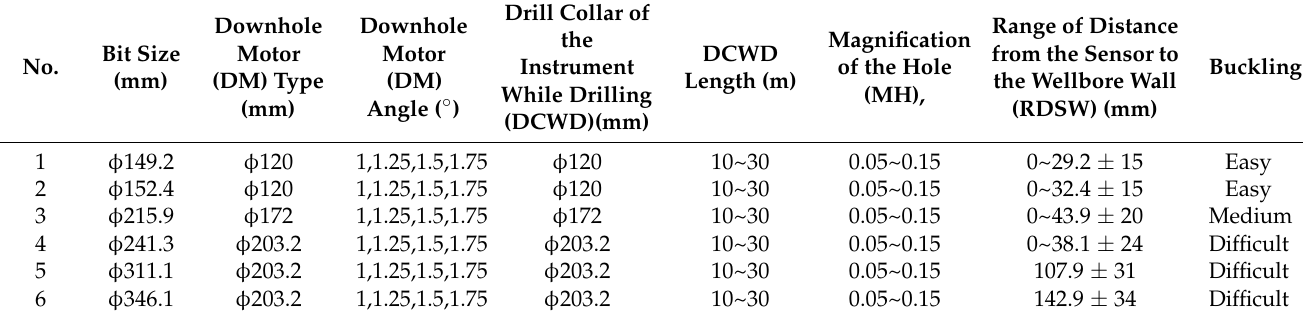
Table 1. Commonly used bottom hole assembly (BHA) table for measurement while drilling and orientation.